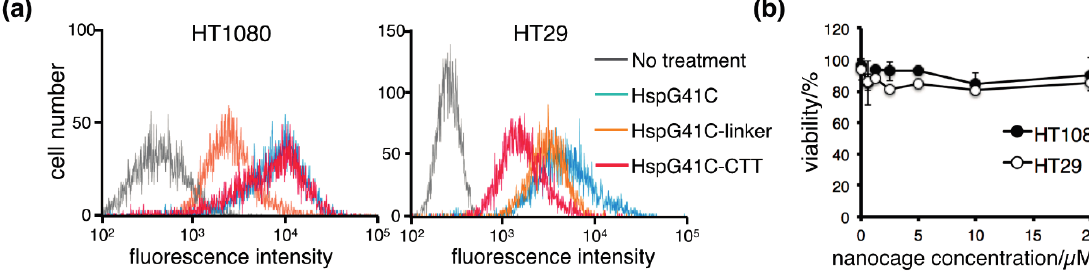
Figure 4. Cellular uptake of the protein nanocages in vitro . ( a ) Representative histograms of the fluorescence intensities of HT1080 and HT29 cells incubated with fluorophore- labeled nanocages in the presence of 10% fetal bovine serum for 3 h; ( b ) Cytotoxicity of HspG41C-CTT in HT1080 and HT29 cells. Data are presented as the mean ± standard error of the mean of three independent